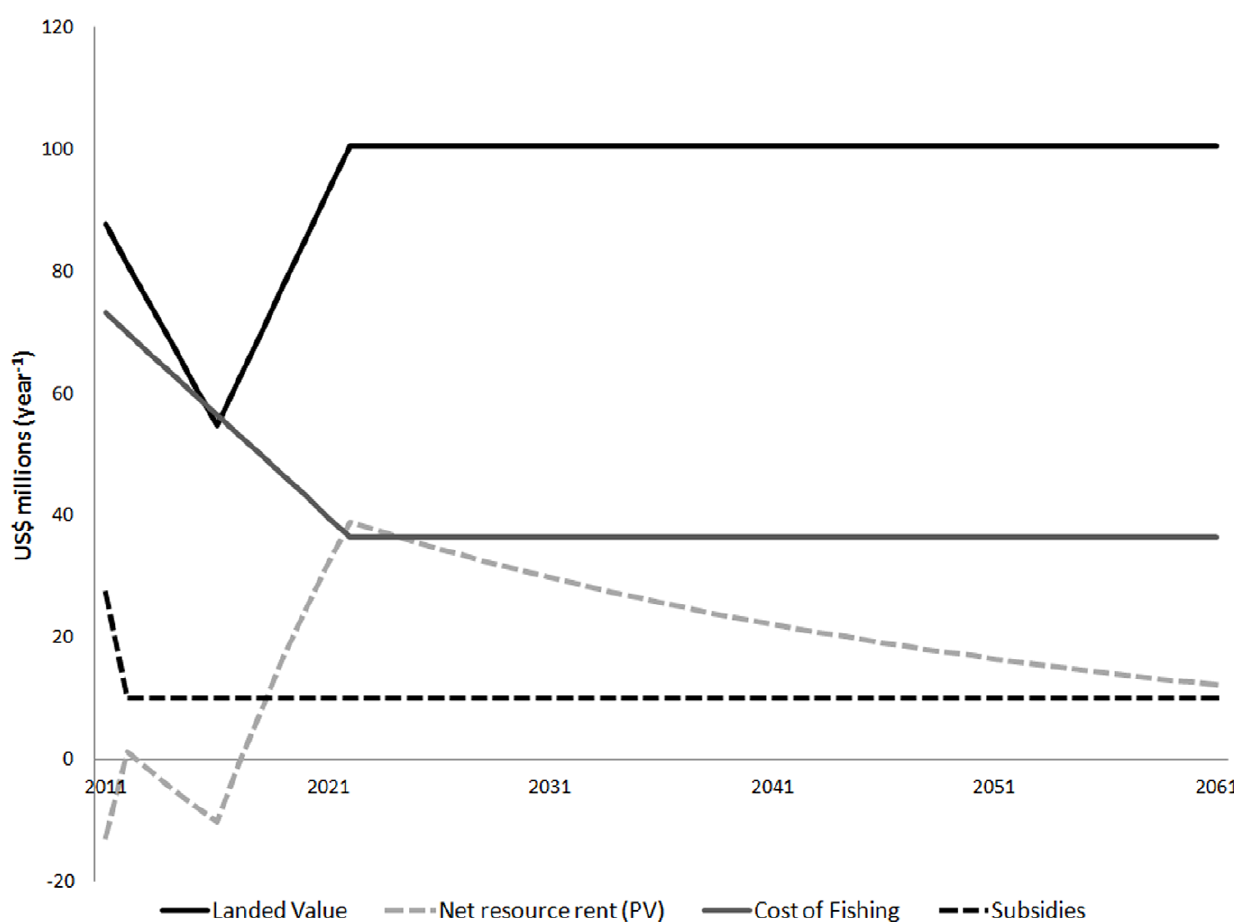
Figure 3. Transition time path of key rebuilding global fisheries variables.